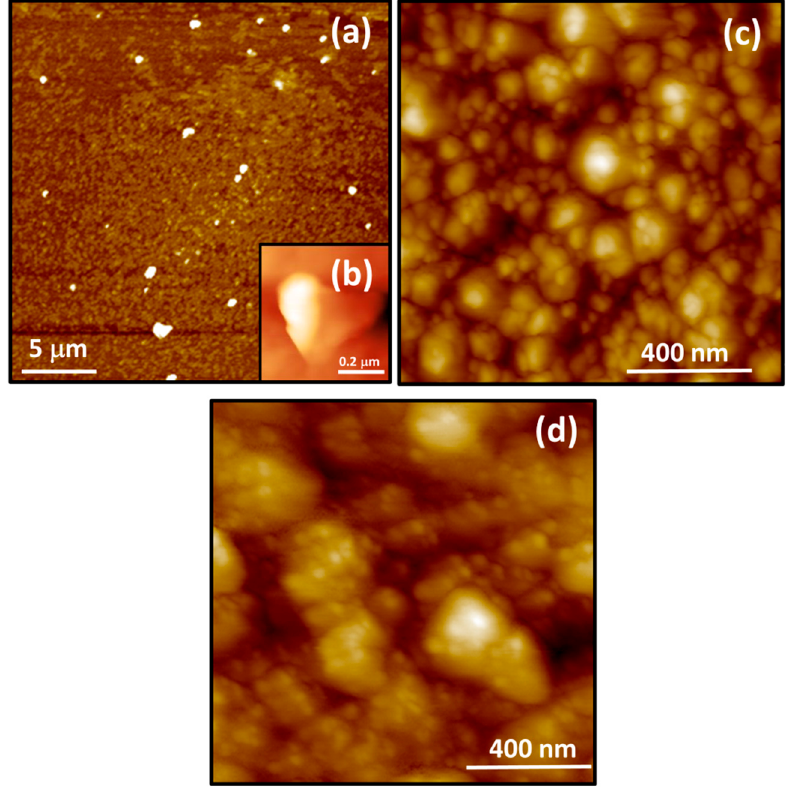
Figure 4. SEM micrographs of ZnO and ZnO-rGO_3 films at different scale (1 µm, 500 nm and 300